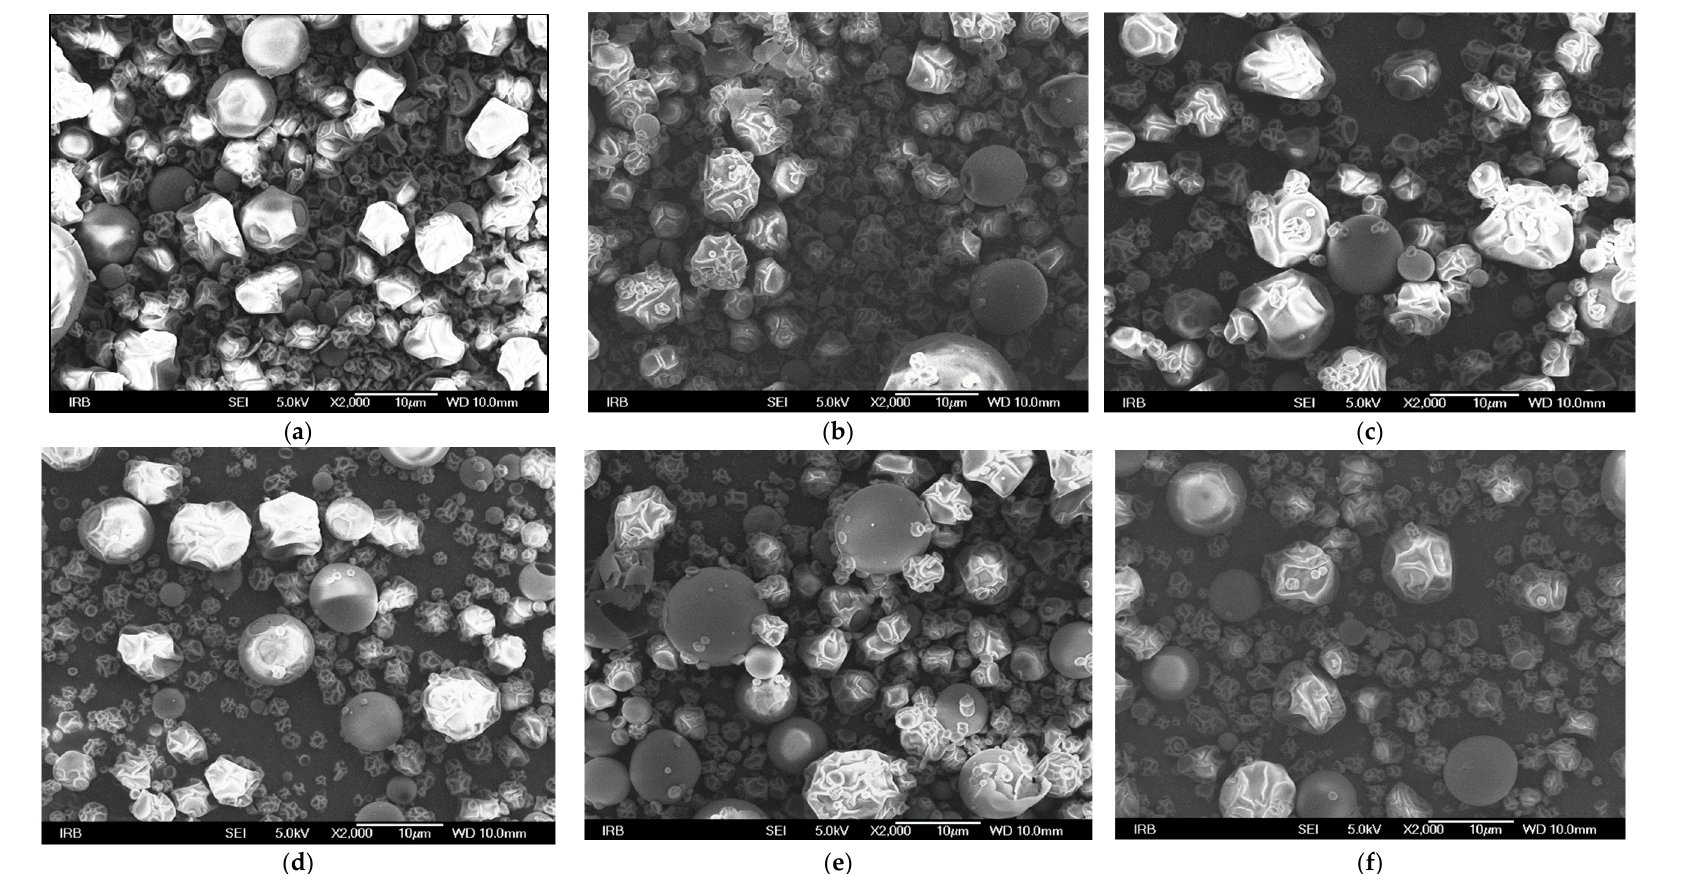
Figure 1. SEM images of the microcapsules of encapsulated nettle leaves extract with different carriers: ( a ) MD ( b ) MD:GA (1:1) ( c ) MD:GA (3:1) ( d ) β -CD ( e ) β -CD:GA (1:1) ( f ) β -CD:GA (3:1) at 160 ◦ C and sample:carrier ratio